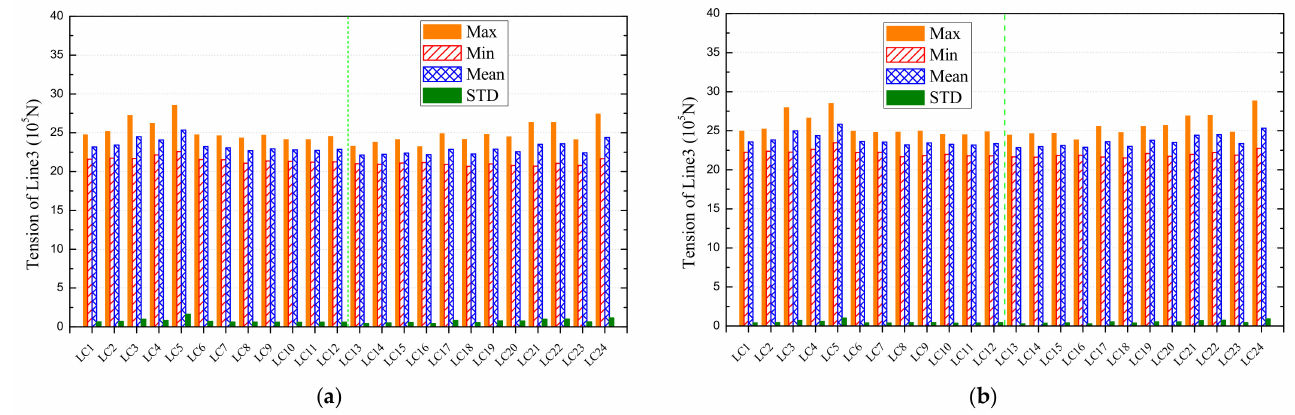
Figure 21. Statistics of mooring tension of line 2 for ( a ) without current; ( b ) with current.